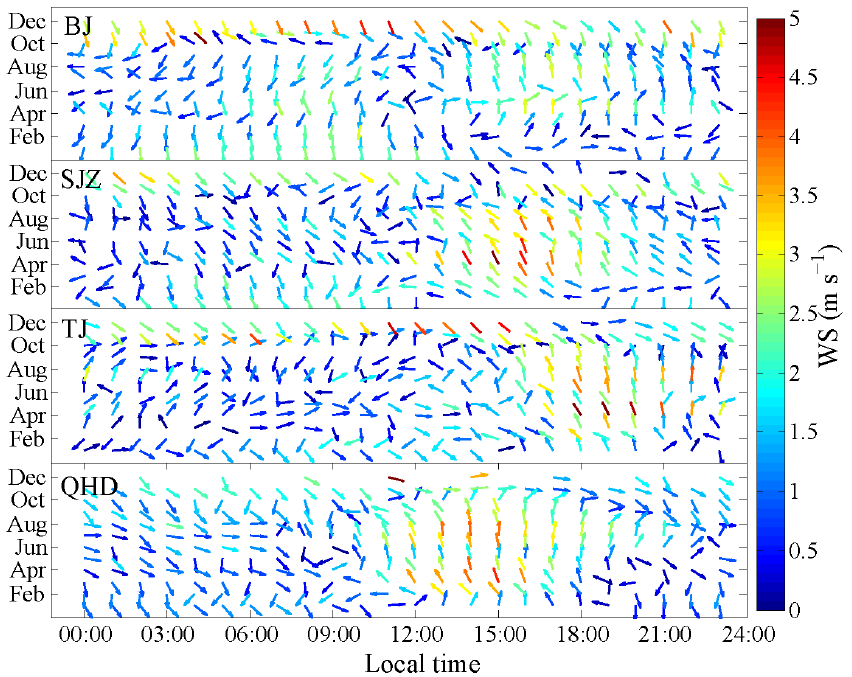
Figure 5. Monthly diurnal wind vectors at the BJ, SJZ, TJ and QHD stations from December 2013 to November